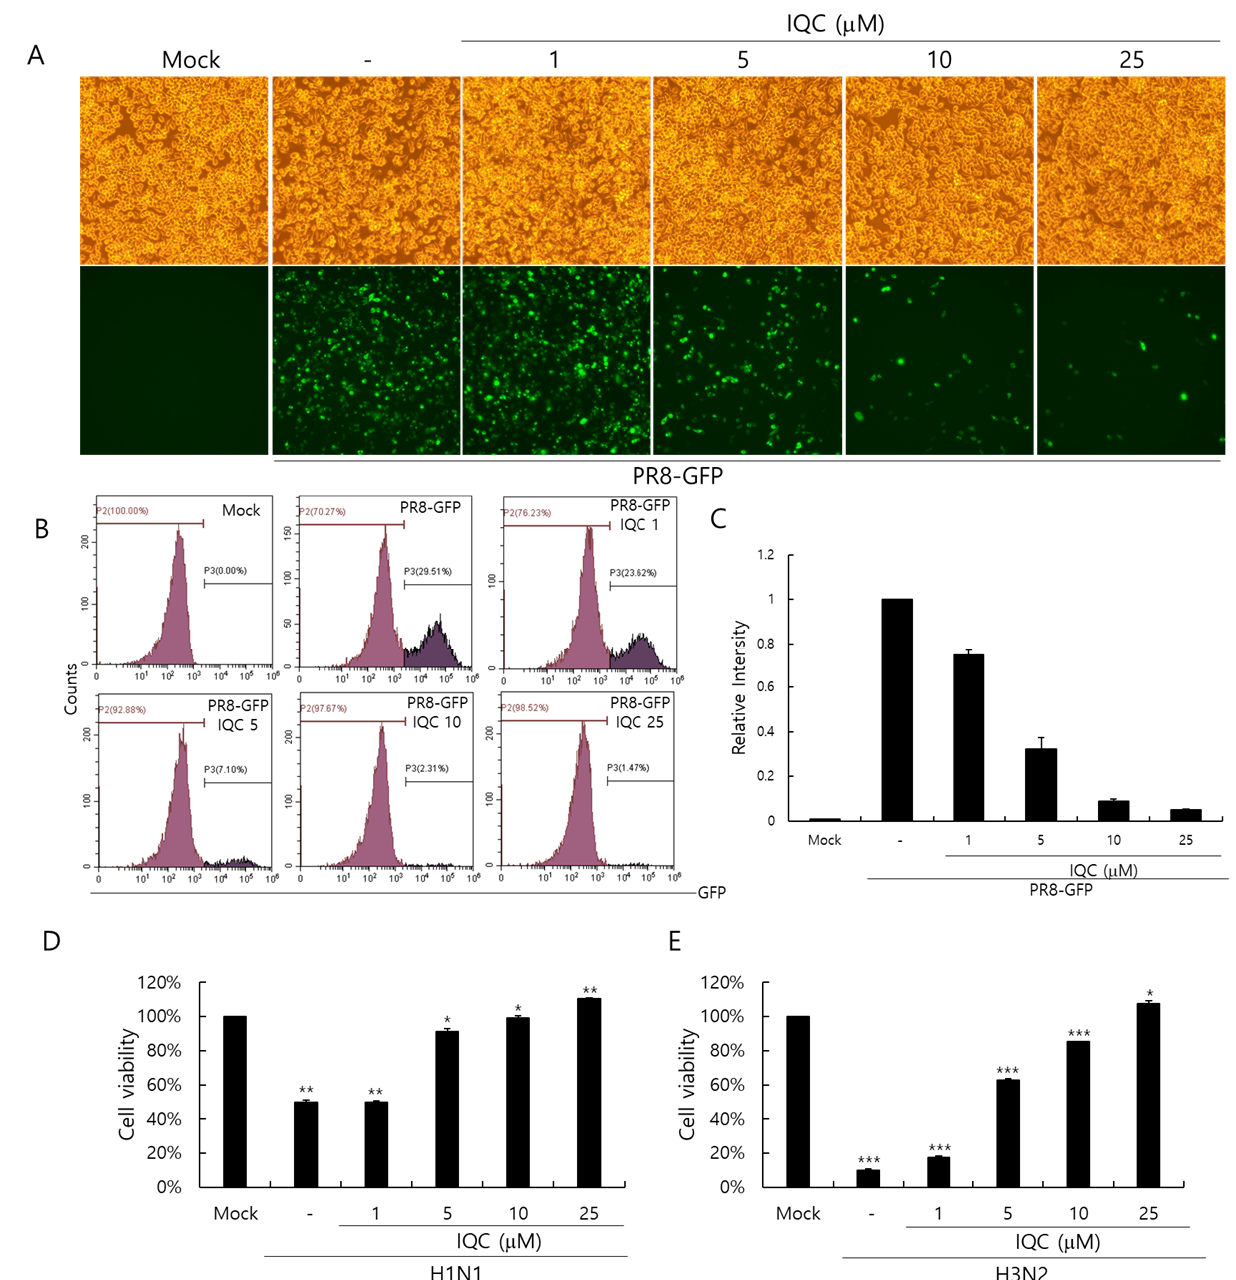
Figure 2. The antiviral effect of isoquercitrin against influenza A viral infection. (A-C) IQC at 0, 1, 5, 10, or 25 µM with 10 MOI PR8-GFP IAV were mixed for 1 h at 4 °C , the mixtures were cotreated to RAW 264.7 cells for 2 h at 37 °C . After washing with PBS, the cells were further incubated for 24 h at 37 °C . ( A ) Brightfield and fluorescence images were obtained using the fluorescence microscope with 200× magnification. ( B , C ) The cells were fixed with 4% paraformaldehyde and analyzed by FACS. The levels of GFP expression were depicted as relative intensities compared to the PR8-GFP IAV-infected control. The data represent the mean ± SD based on three independent experiments. ( D ) H1N1 or ( E ) H3N2 IAV at 50 MOI was incubated with IQC at the indicated concentrations 1 h at 4°C and the mixture was added to the cells until cytopathic effect formation at 37 °C . The super-